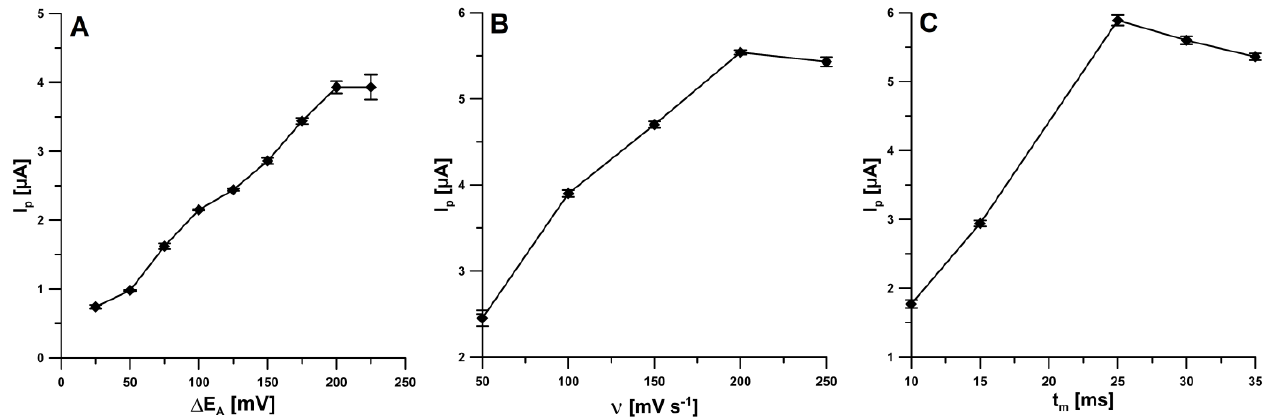
Figure 3. Effect of ΔE A ( A ) , ν ( B ) and t m ( C ) on the analytical signal of 20.0 µM